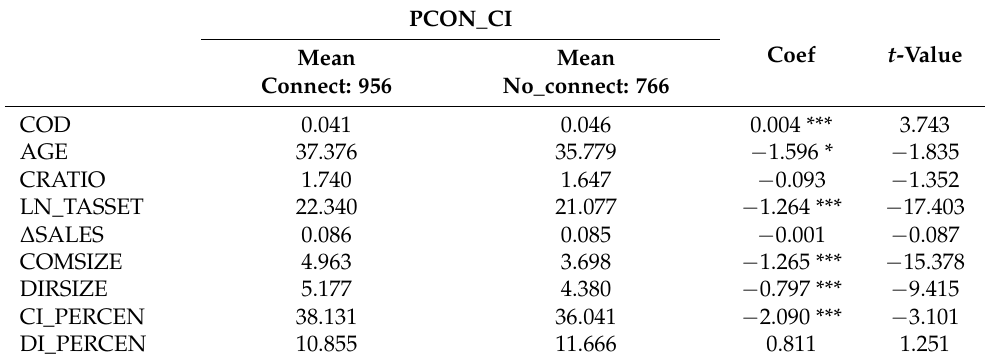
Table 6. Independent t -test of Variable Politically Connected Independent